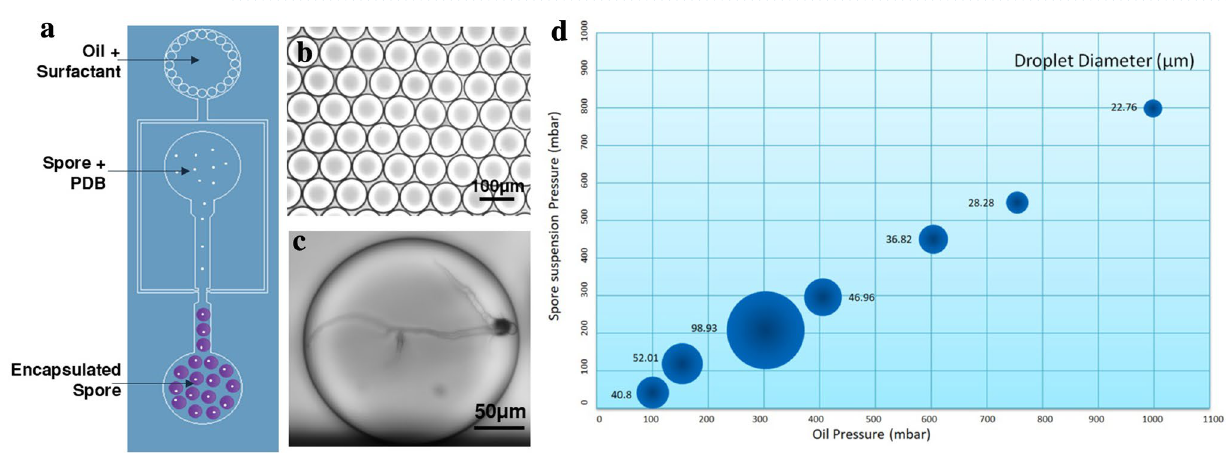
Figure 2. ( a ) Schematic representation of droplet generation chip for single spore encapsulation, ( b ) highly monodisperse droplets (100 µm), ( c ) encapsulated spore of Alternaria alternata showing branched hyphal growth after 24 h of incubation inside a droplet, ( d ) correlation of droplet size and pressure for the surface at a depth of 50 μm, to a glass slide. Through bonding of the structured PDMS surface onto a glass slide, the channels and two inlets were created, first for oil (with surfactant) and second for spore suspension (in half strength PDB). Half strength PDB was used to avoid variability in spore germination. The size of the nozzle was 50 μm and the droplets were produced by flow-focusing of the aqueous stream with two streams of fluorinated oil containing surfactant (Fig. 2a) (see Supplementary Movie S1). The designed chip enabled the generation of monodispersed droplets in PDB in oil and encapsulation of single spores of Alternaria alternata in PDB (Fig. 2a,b). To set the optimal conditions for single spore encapsulation, various pressures for oil and spore sus-